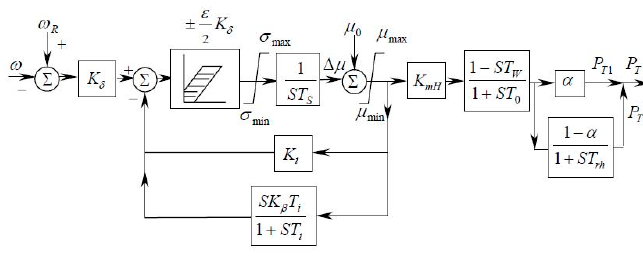
Figure 2. Governor model.